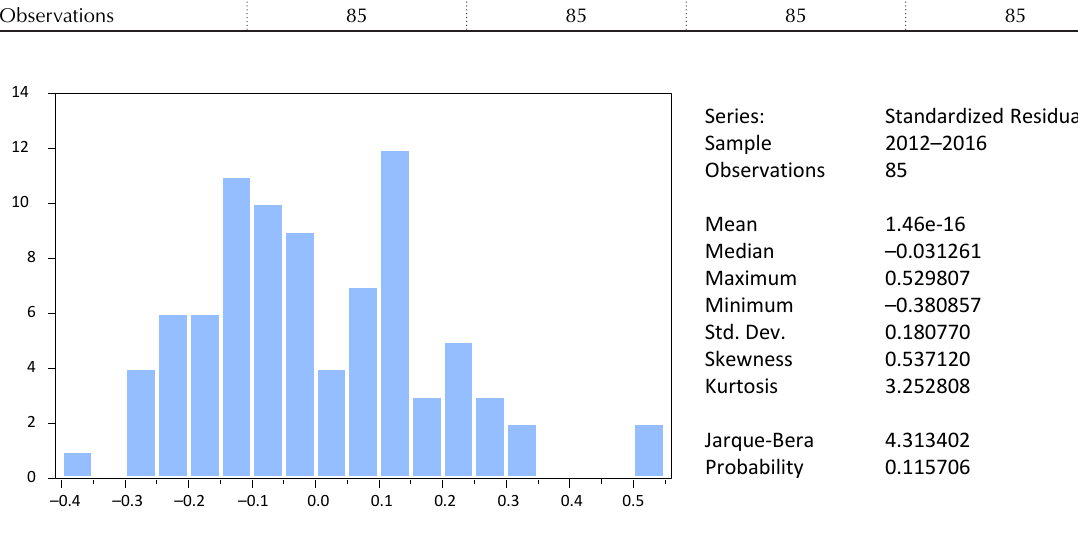
Figure 1. Histogram normality